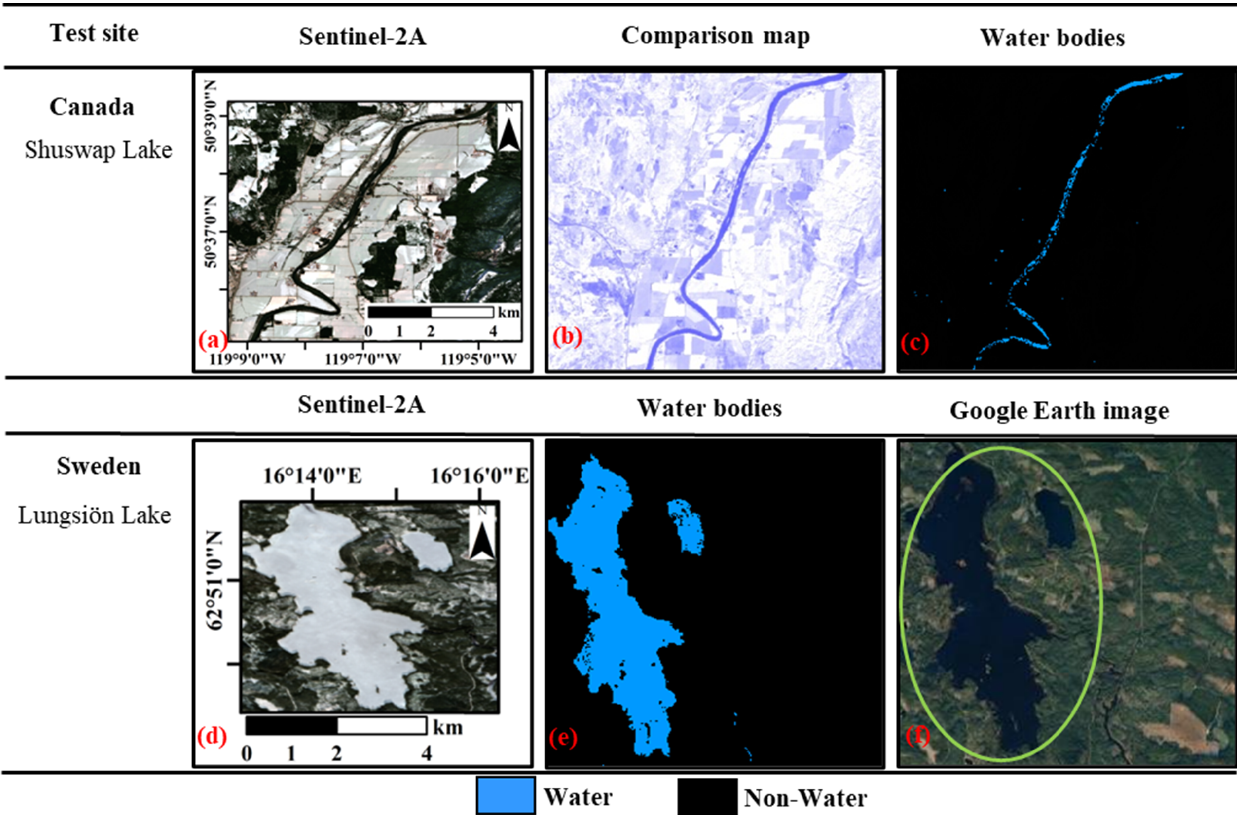
Figure 5. The results of water extraction using the TWI at three selected test sites. Sentinel-2 color composite bands 4, 3, 2 coded RGB. Google Earth Imagery: courtesy of Earth View.